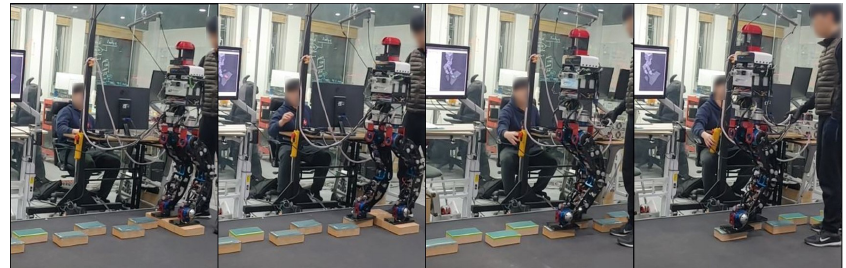
Figure 13. The experiment of Scene 1.